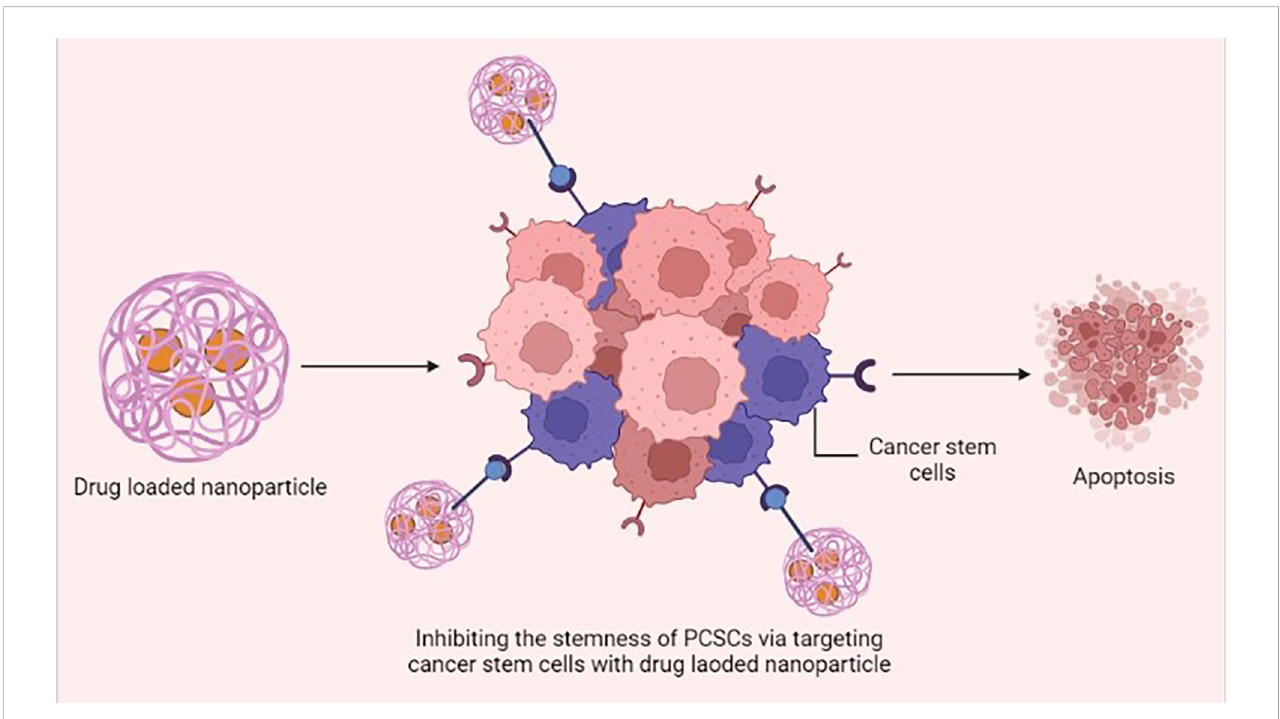
FIGURE 3 Drug-loaded nanoparticles inhibiting the stemness of prostate cancer stem cells (PCSCs) via speci fi cally targeting the cancer stem cells and inducing apoptosis. This fi gure was created with